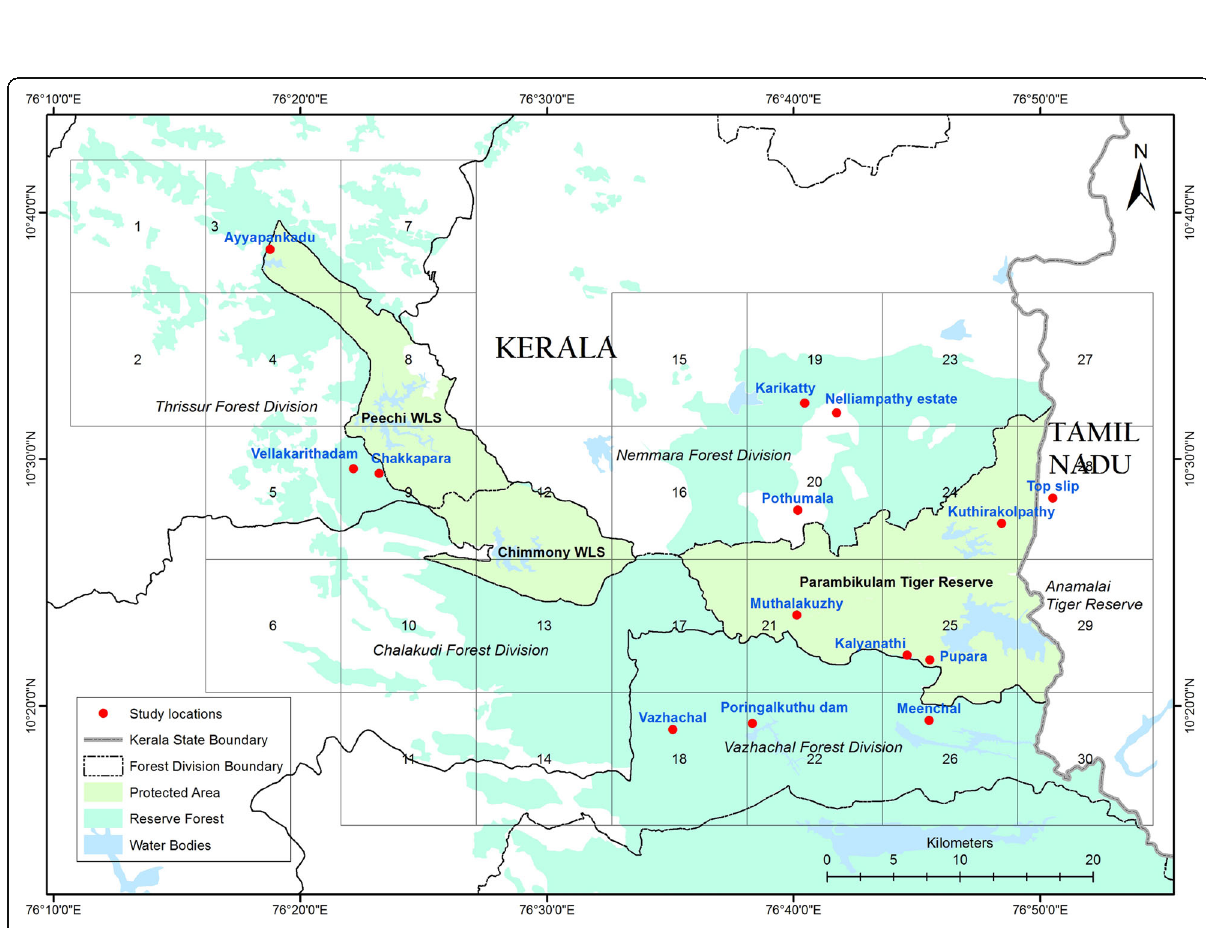
Fig. 10 Locations of range-restricted species within study